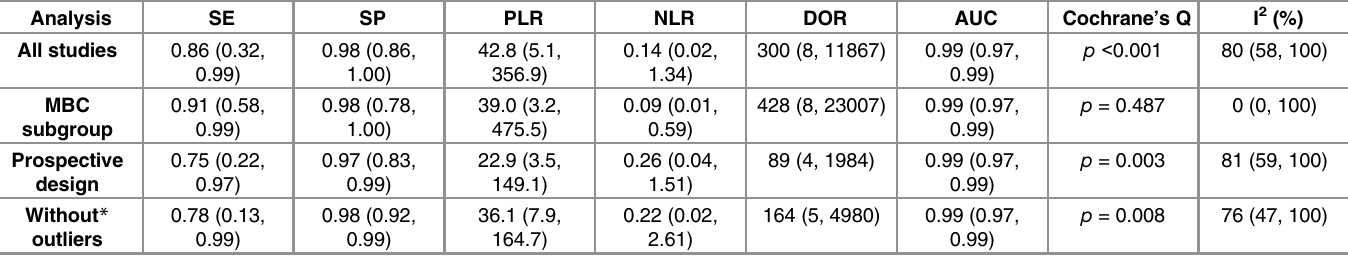
Table 2. Pooled results and subgroup analysis of the meta-analysis for the diagnostic accuracy of PIK3CA mutation detection in cfDNA. Analysis